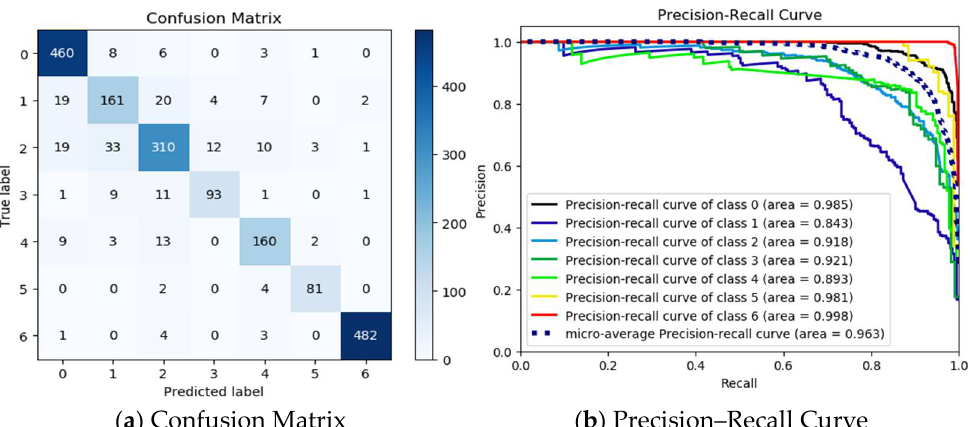
Figure 13. Confusion Matrix and Precision–Recall Curve.